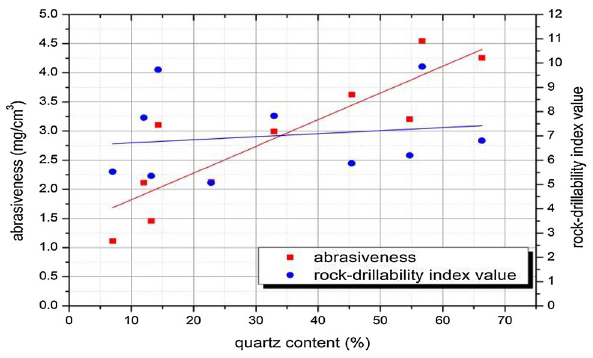
Fig. 9 The influence of quartz content on rock drillability and abra-